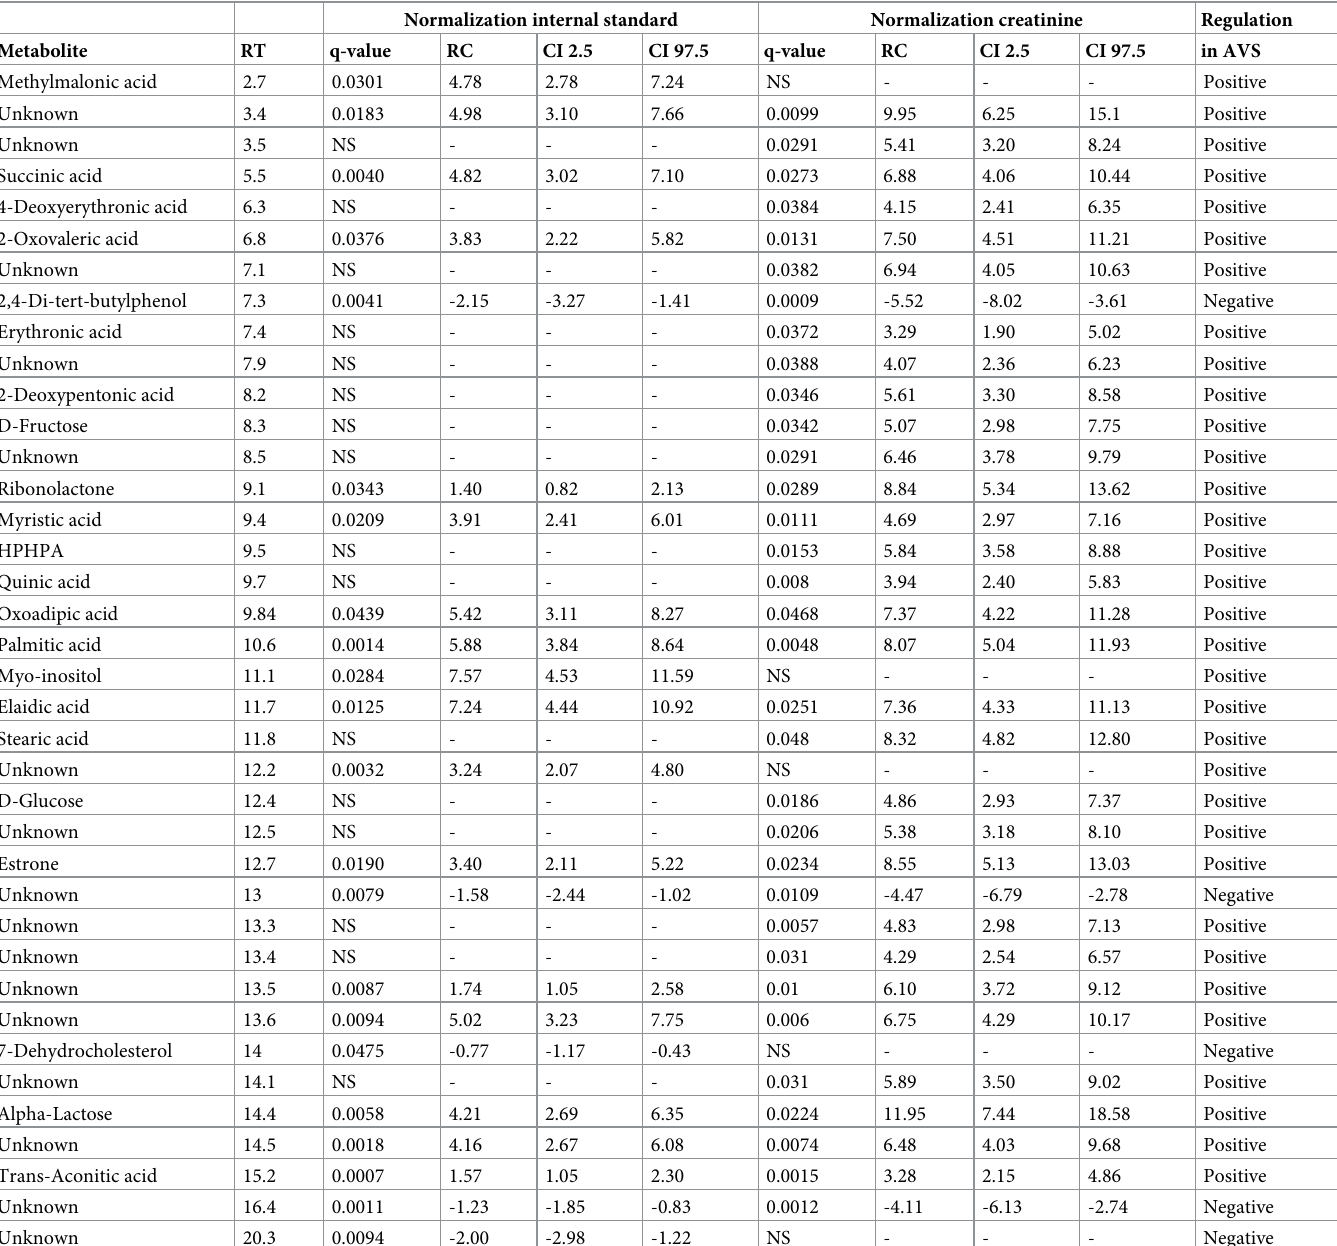
Table 2. Urinary metabolites contributing to the separation between the AVS patients and healthy